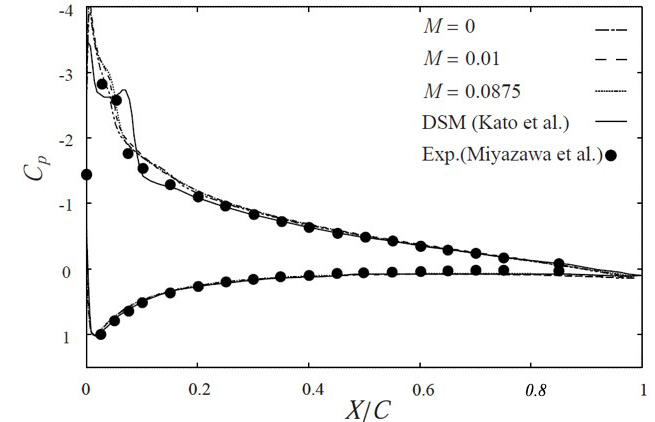
Figure 3. Effect of mesh resolution on C prms at M = 0.0875.